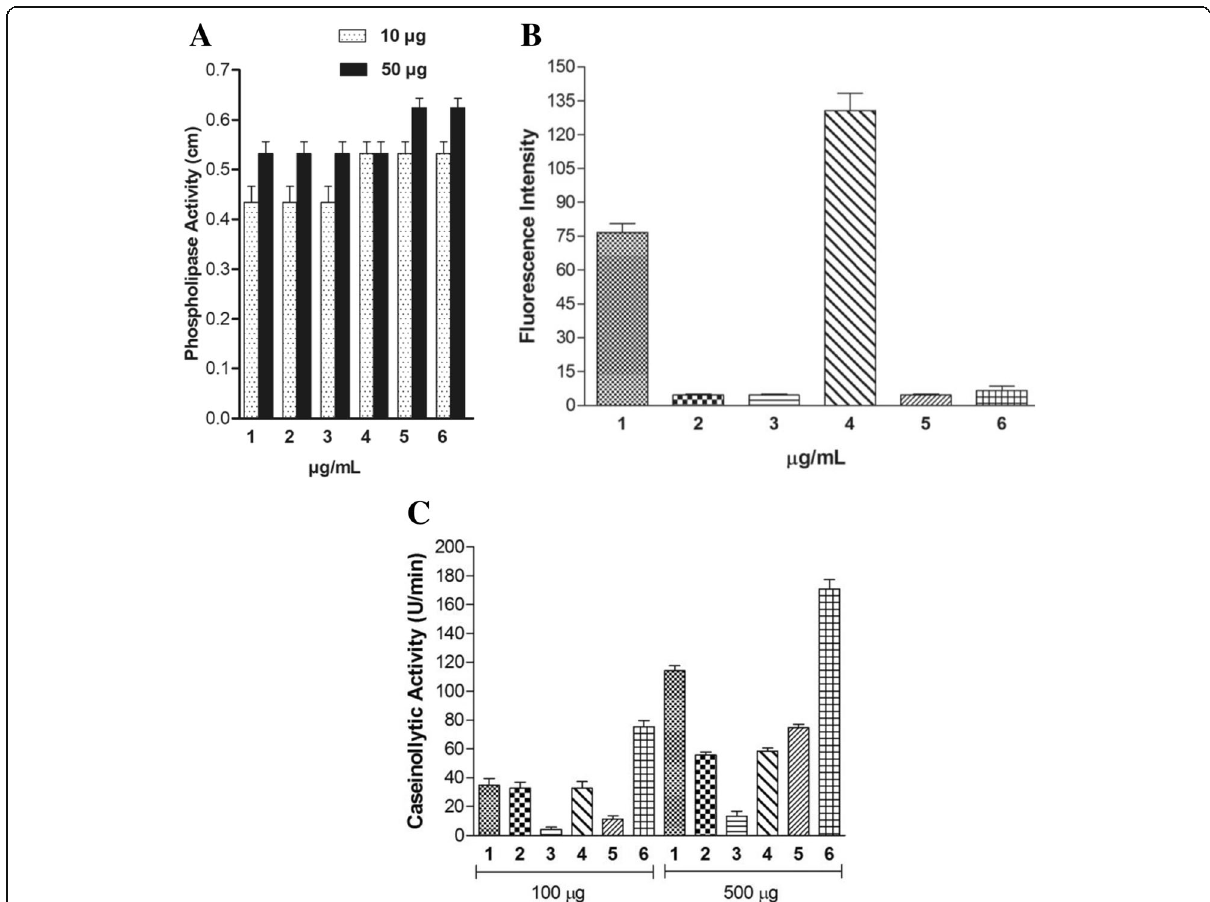
Fig. 2 Phospholipase and proteolytic activities induced by cnidarian extracts. (1) C. gigantea (body-wall), (2) C. gigantea (total), 3) M. alcicornis, (4) S. helianthus (5) P. homomalla and (6) B. annulata. ( a ) The PLA 2 activity using the indirect hemolytic assay on agarose gels containing red blood cells and egg-yolk phospholipids and by ( b ) Hydrolysis of the NBD-PC by cnidarian extracts (1 – 6). ( c ) Proteolytic activity upon 1% casein evaluated with 100 and 500 μ g of cnidarian extracts for 30 min at 37 °C. Results are reported as mean %±SD ( n